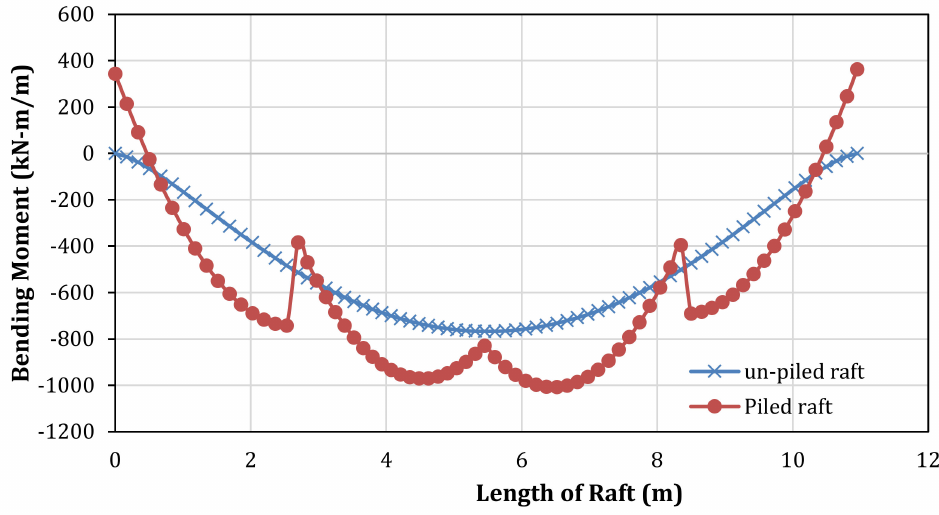
Figure 13. Bending moment, un-piled and piled